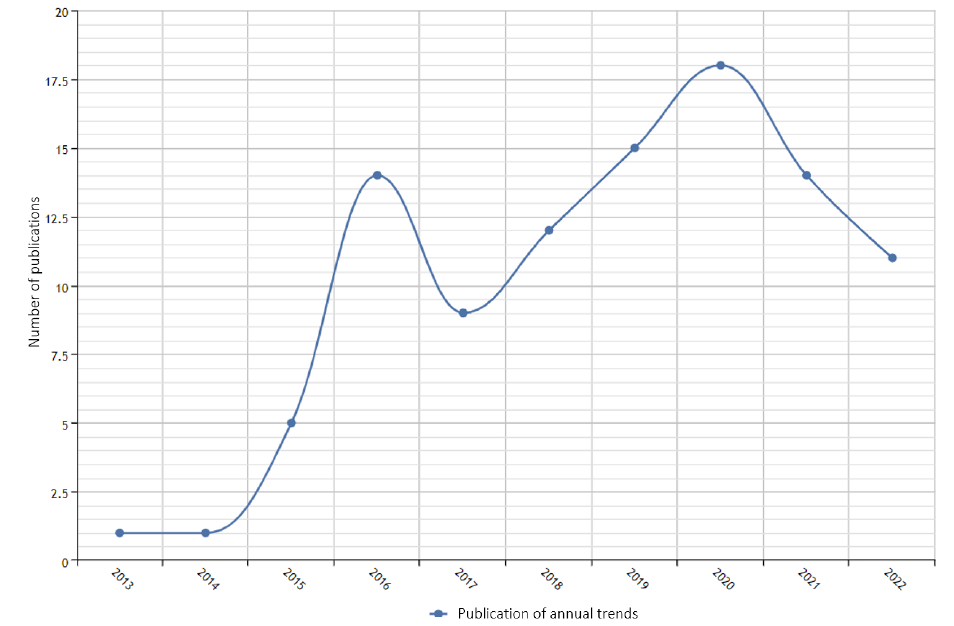
Figure 2. The number of publications of tumor big data visualization on CNKI from 2013 to